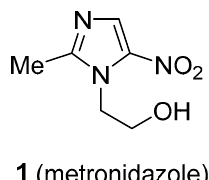
Figure 1. Structure of metronidazole.